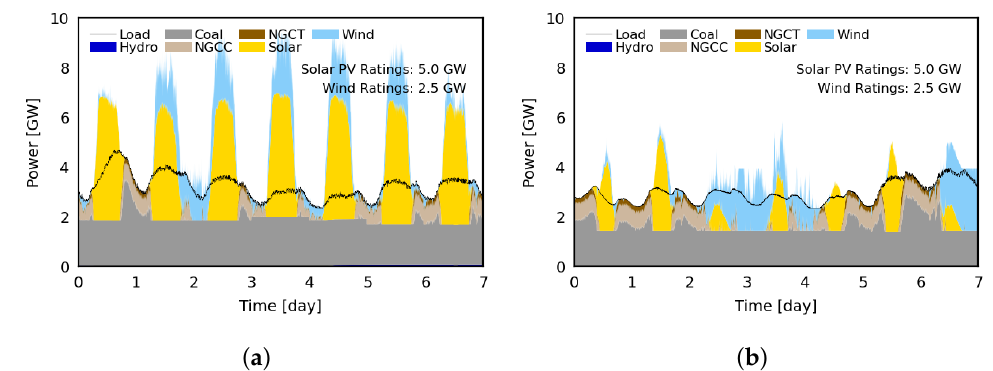
Figure 6. Example weeks of economic dispatch with a coal-dominated scenario for ( a ) a high renewable capacity factor week from May 8–14 and ( b ) low renewable capacity factor week from January 8–14. Renewable output may need to be significantly curtailed compared to natural-gas dominant generation due to slow turn-down and start-up times specific to coal operation as a base load.